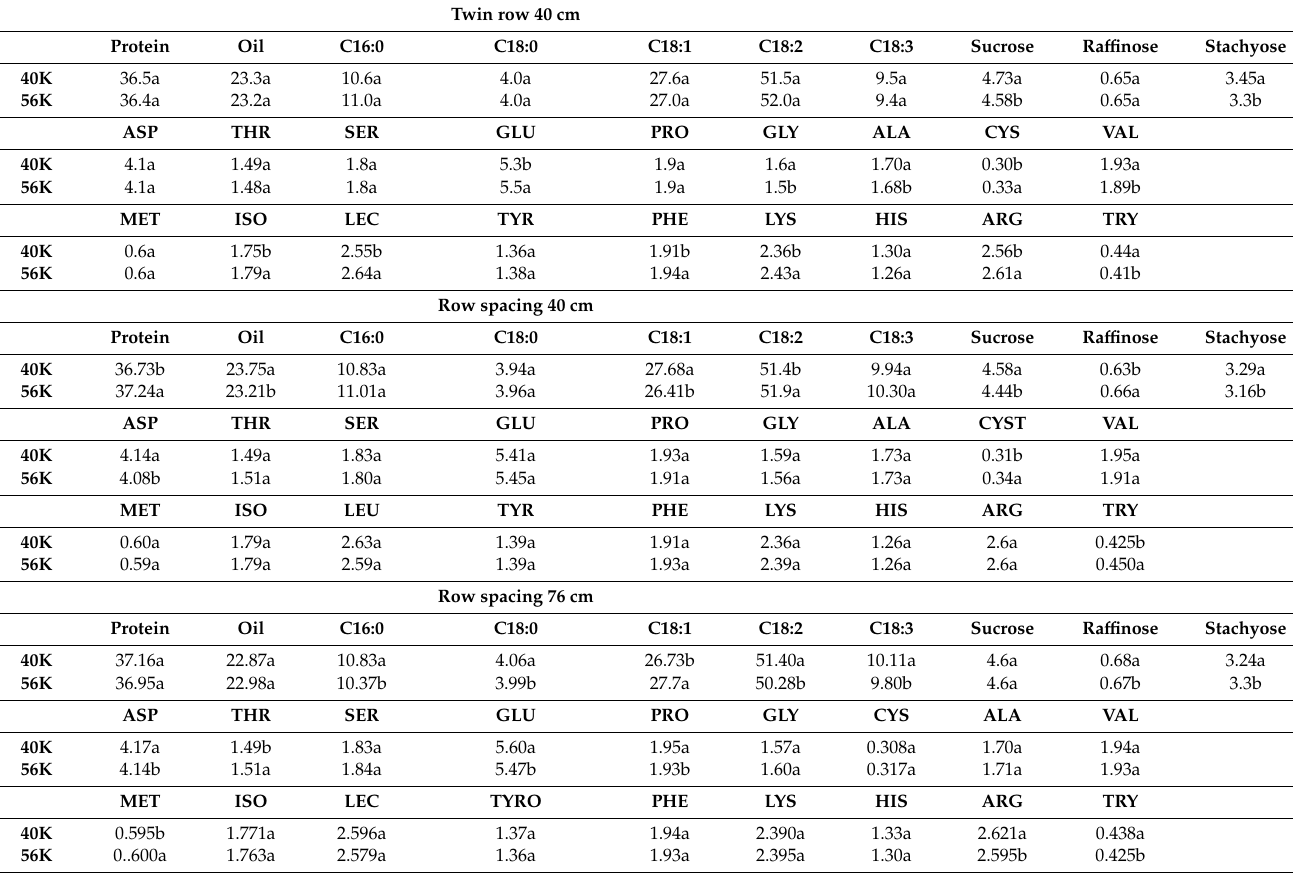
Table 7. The e ff ect of seeding rate and row spacing (15 inches twin row, 15 row spacing, and 30 row spacing (40 cm and 76 cm, respectively) on seed composition (protein; oil, palmitic (C16:0), stearic (C18:0), oleic (C18:1), linoleic (C18:2), linolenic (C18:3); sugars (sucrose, ra ffi nose, stachyose) (%); and amino acids aspartic acid (ASP), threonine (THR), serine (SER), glutamic acid (GLU), proline (PRO), glycine (GLY), alanine (ALA), cystine (CYS), valine (VAL), methionine (MET), iso-leucine (ISO), leucine (LEU), tyrosine (TYR), phenylalanine (PHE), lysine (LYC), histidine (HIS), arginine (ARG), and tryptophan (TRY) (%) in cultivar P 47T36R, in 2015. Twin row 40 cm